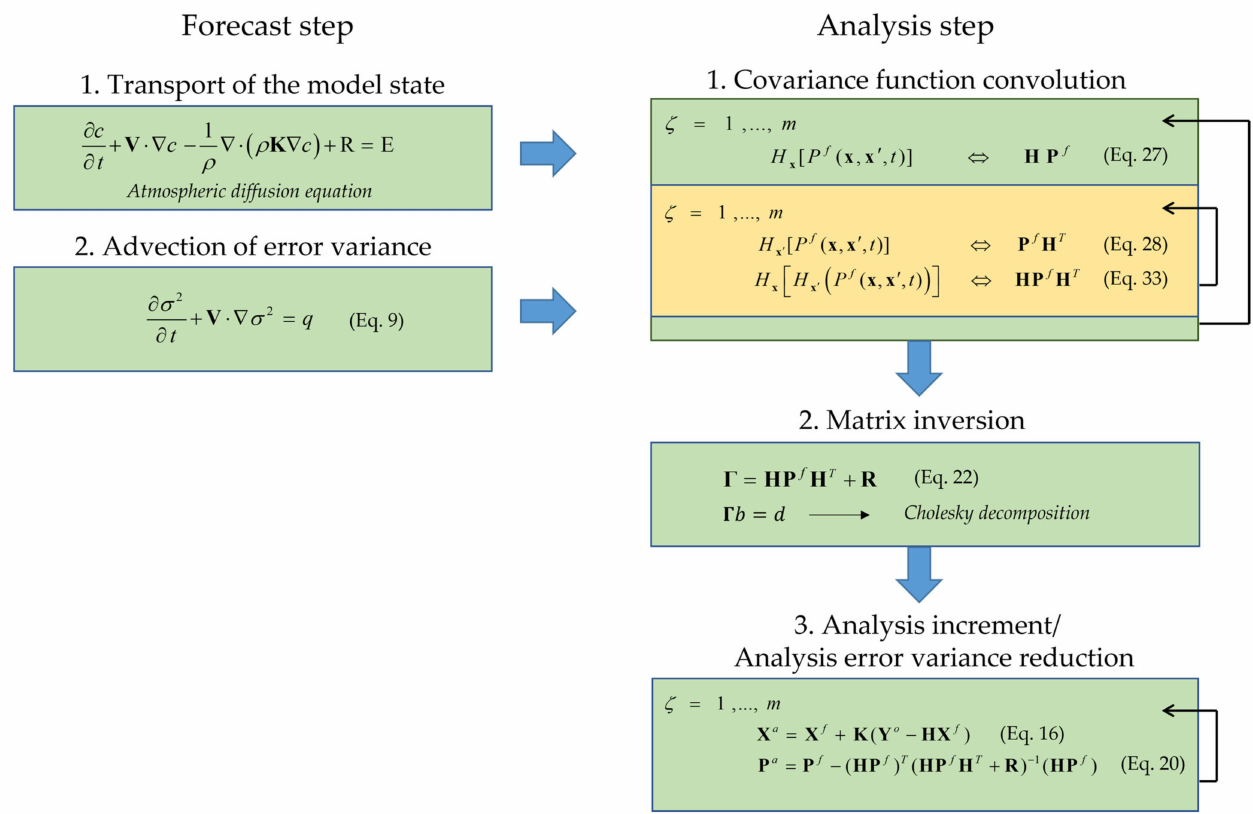
Figure 1. Flowchart of the analysis and forecast steps of the PvKF assimilation. In the forecast step, the transport of the model state uses the atmospheric diffusion equation